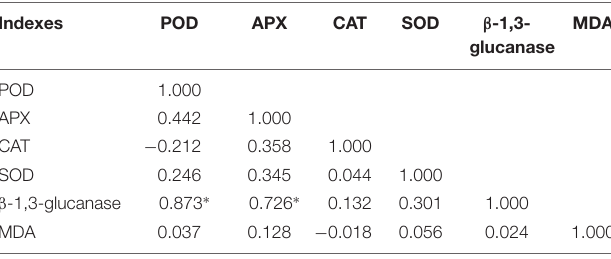
Values in the same column with the different letter were significantly different (P- value < 0.05) calculated using one-way analysis of variance (ANOVA) followed by multiple Duncan tests. POD, peroxidase; APX, ascorbate peroxidase; CAT, catalase; SOD, superoxide dismutase; MDA, malonaldehyde. TABLE 3 | Correlation matrix of test